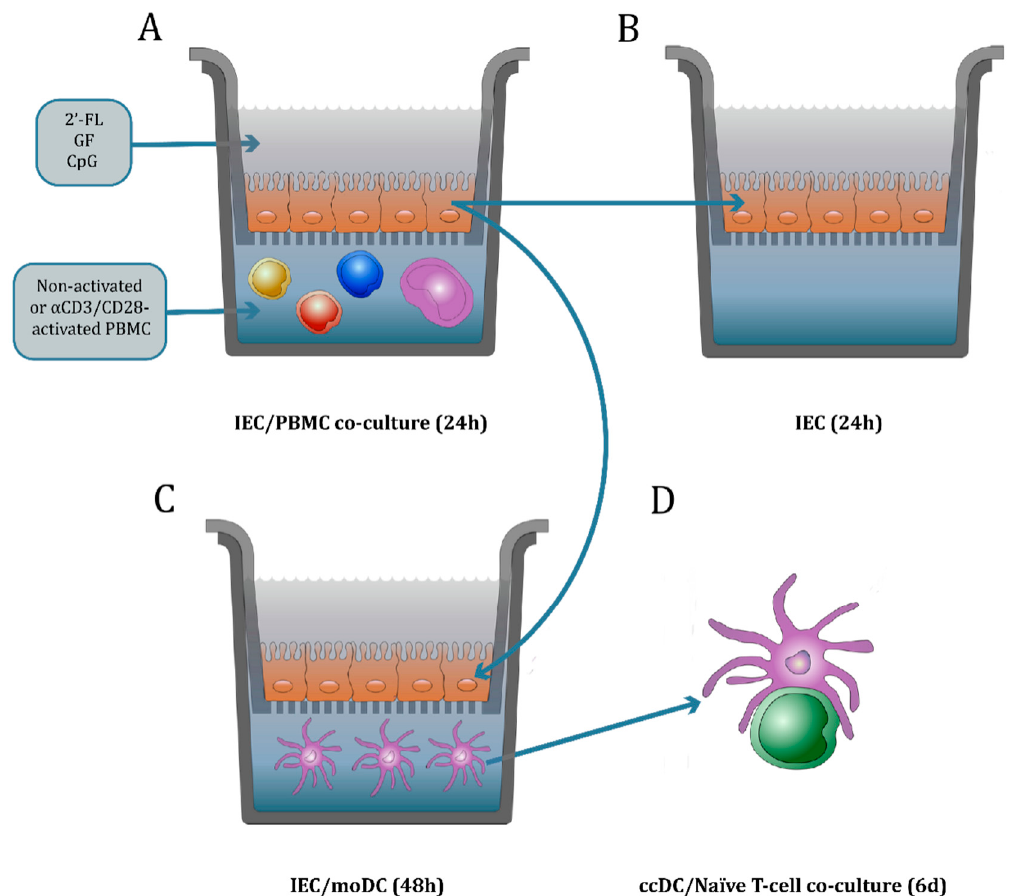
Figure 1. Co-culture model description. IEC were grown in 12-well transwell inserts until